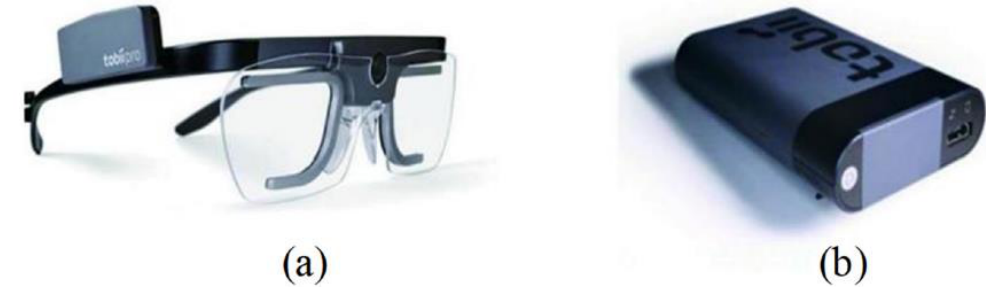
Figure 2. Eye-tracking experimental setup consisting of ( a ) a data acquisition unit and ( b ) a data recording unit.